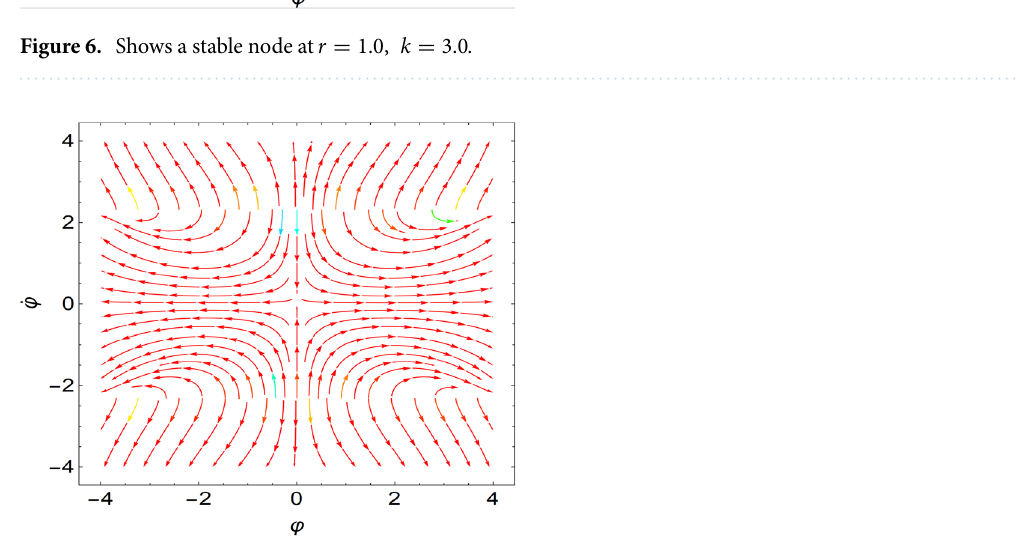
Figure 7. Shows a stable node at r = 3.0, k = 1.0